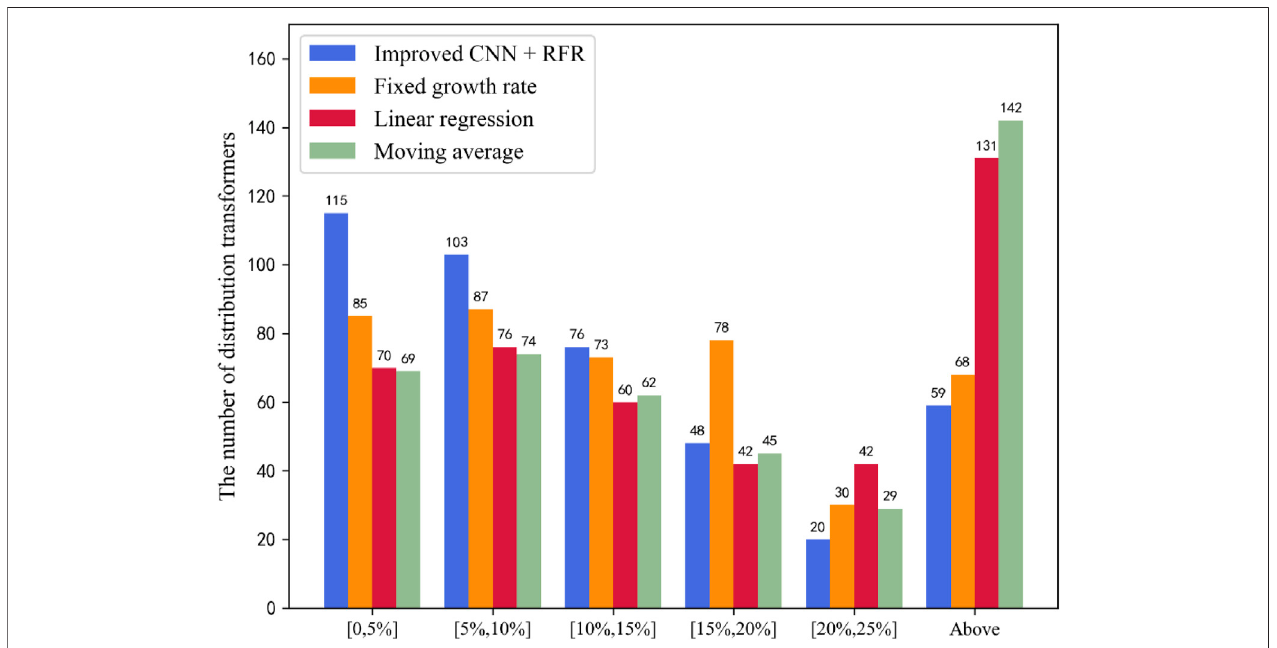
FIGURE 13 | The number of distribution transformer in different error interval.